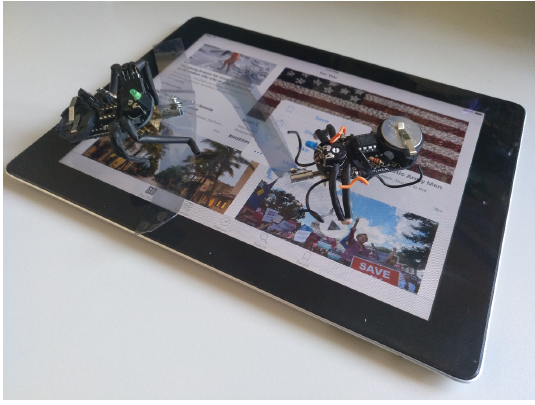
Figure 2. Interfight by César Escudero